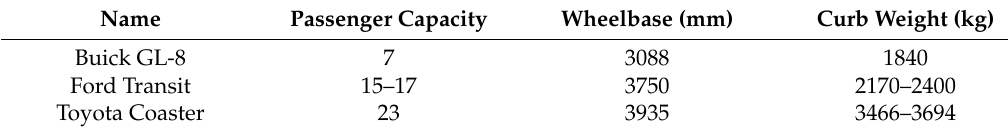
Table 1. Vehicle